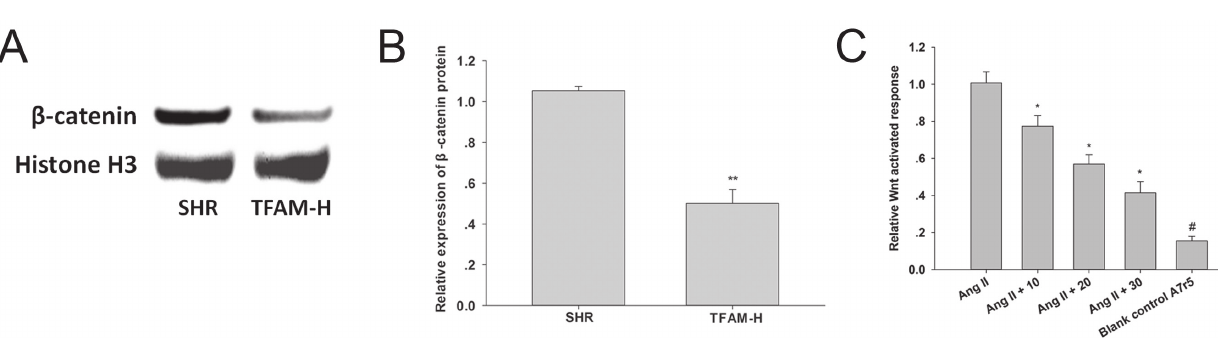
FIGURE 4 - TFAM could suppress Wnt/β-catenin signaling in vascular smooth muscle cells. (A) TFAM decreased protein expression of β-catenin in western blot assay. (B) Bars represent the intensity of the bands of (A), quantitated by densitometry. The values given are the mean ± SD. n = 3, * P <0.05, compared with the SHR group. (C) The TOPflash luciferase assay showed the effect of TFAM on high activation of TCF/LEF transcription in Ang II-stimulated A7r5 cells. A7r5 cells were transfected with a TOPflash or FOPflash reporter construct and either TFAM or no treatment. The TOPflash luciferase activity was measured after 48 h post- treatment. Values represent the mean ± SD. n = 3, * P <0.05, for TFAM treated cells versus the cells in Ang II group. # P <0.05, for cells of blank control group versus the cells in Ang II